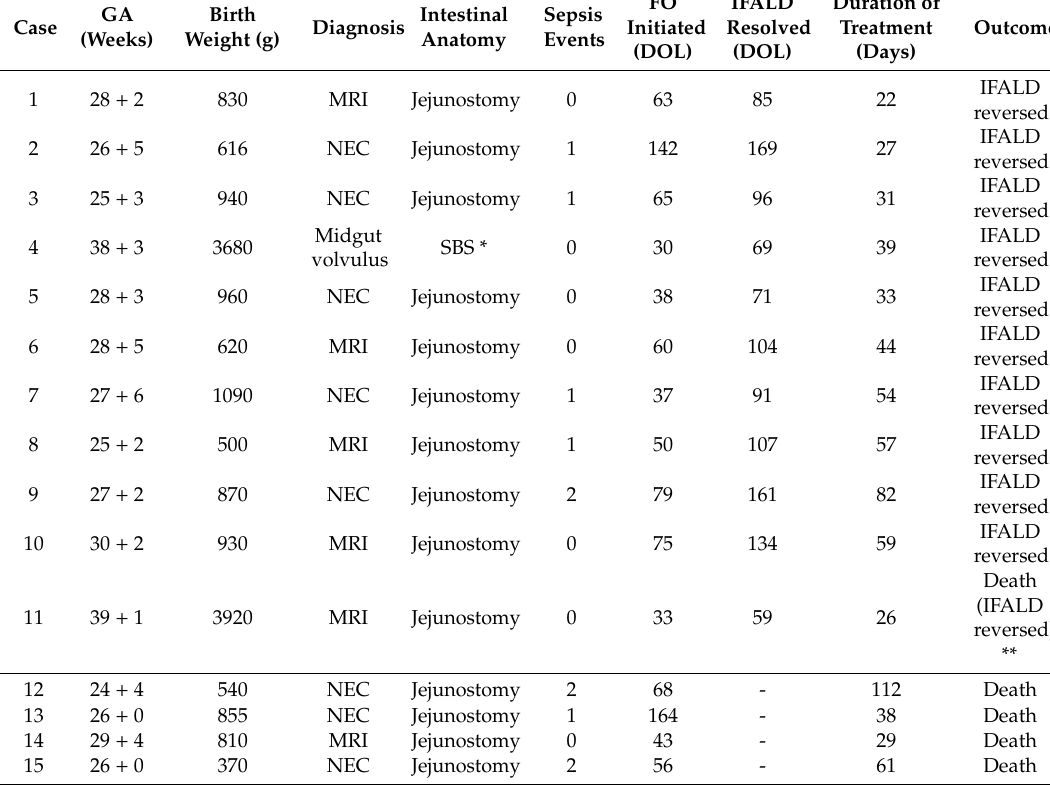
Table 1. Clinical characteristics and outcomes of infants.